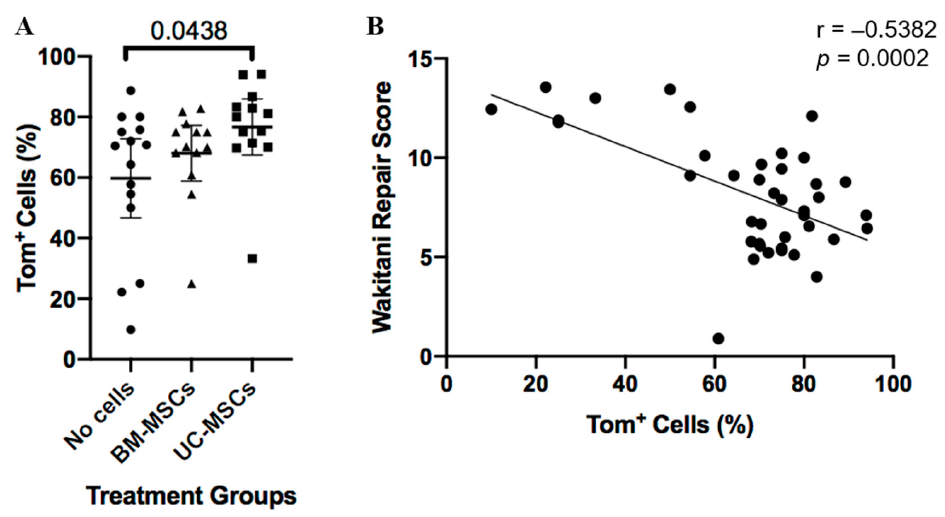
Figure 4. Tomato positive (Tom+) cells in repair tissue. ( A ) Cell-treated groups had more tomato- positive cells compared to the no cell control group, but this was only significant for human UC-MSCs. This indicated that a greater number of cells populating the repaired region originated from the murine joint interzone, as shown by Tom+ staining. Data are presented as the mean ± 95% CI. ( B ) Percentage of Tom+ cells within the repair tissue plotted against the Wakitani scores for all knee joints from all treatment and control